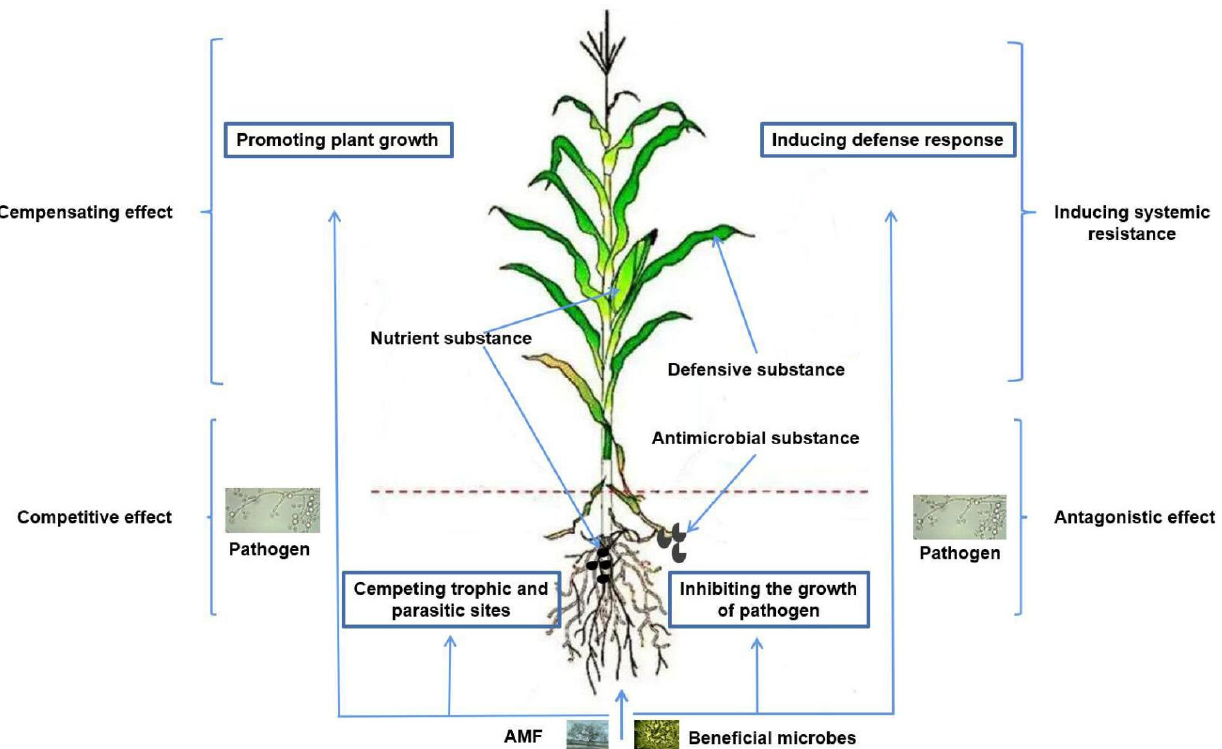
Figure 1. Schematic diagram of the mechanism of joint control of plant diseases by AMF and beneficial microorganisms.